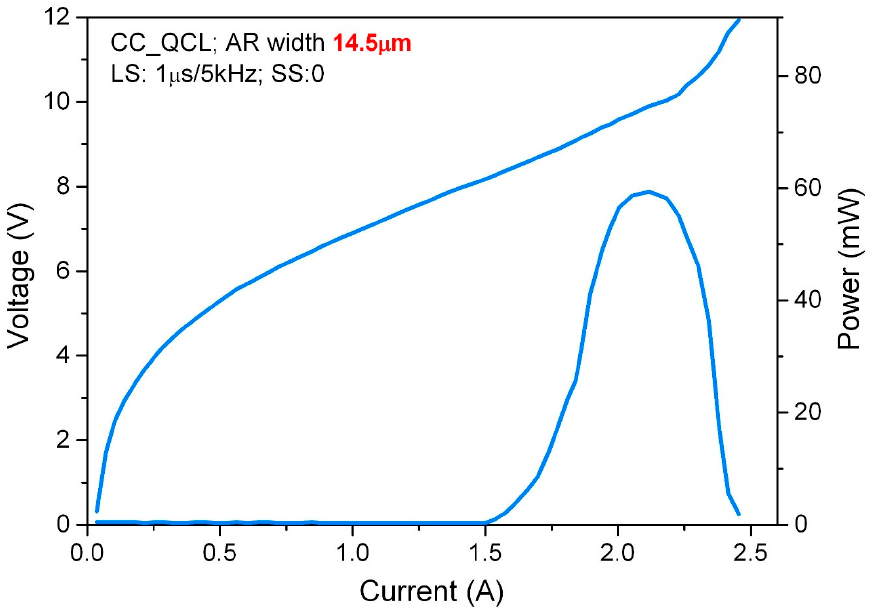
Figure 11. L–I–V curves of CC-QCL. The long section is driven in pulse mode with 1 µ s pulses and repetition rate 5 kHz. The short section is unbiased.